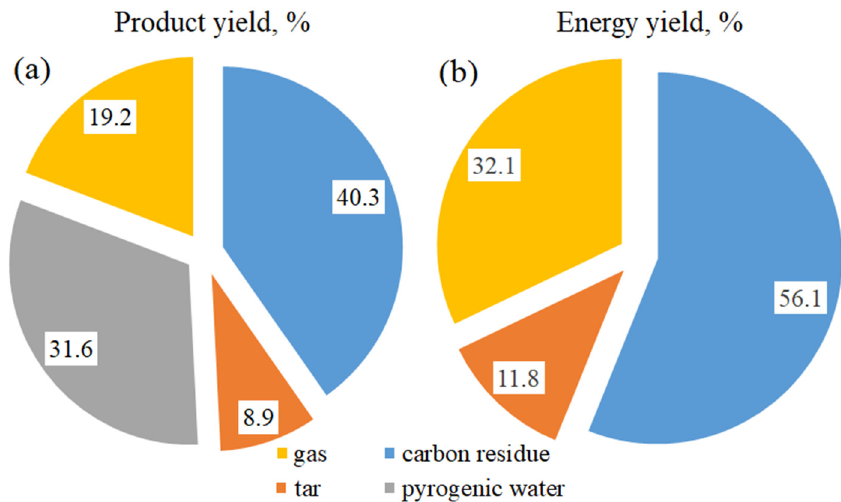
Figure 4. Material ( a ) and energy balance ( b ) of pyrolytic products.